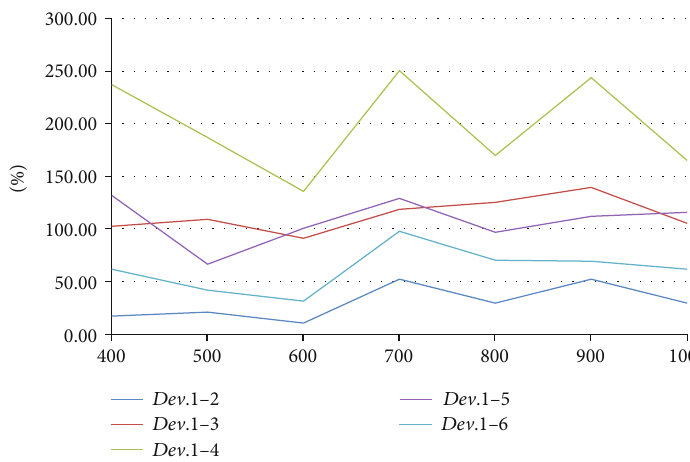
Figure 4: Results of Dev .